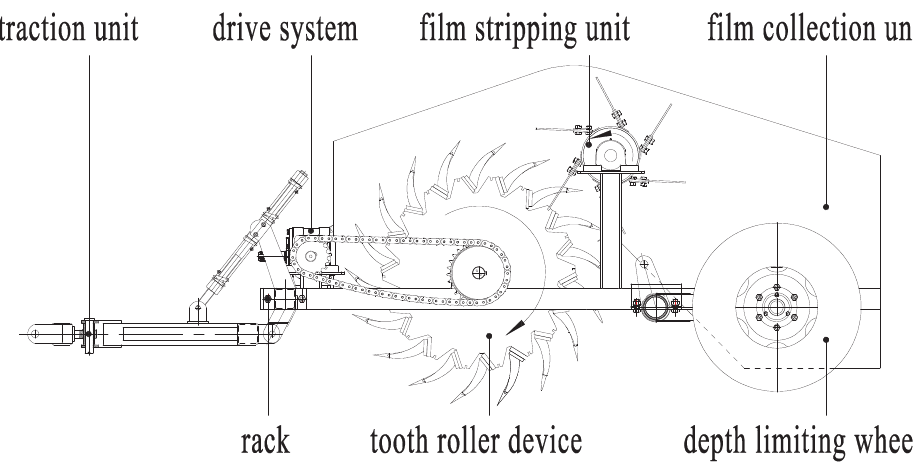
Figure 1. Structure of the residual film recovery machine.